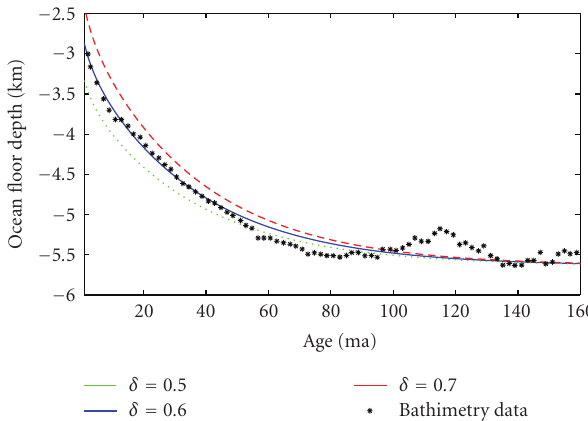
Figure 9: Results of numerical simulations illustrating the response of VBA model to change in the value assumed for the bathymetry constant δ . The square symbols indicate mean oceanic bathymetry values.